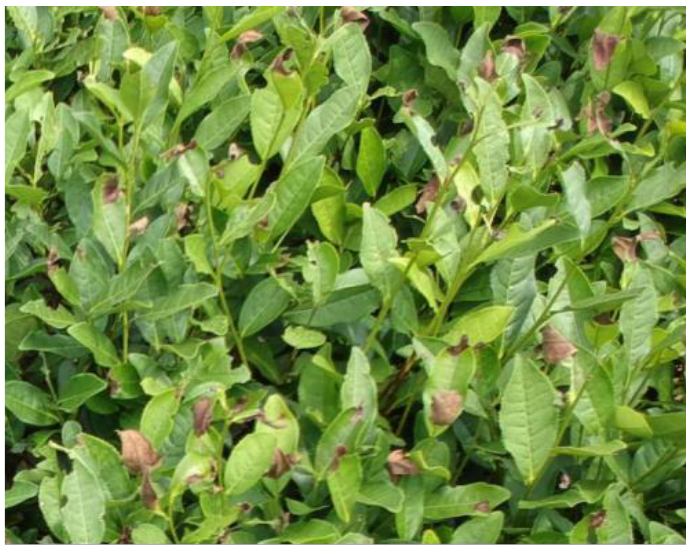
Figure 2. Tea leaf blight is a tea disease.